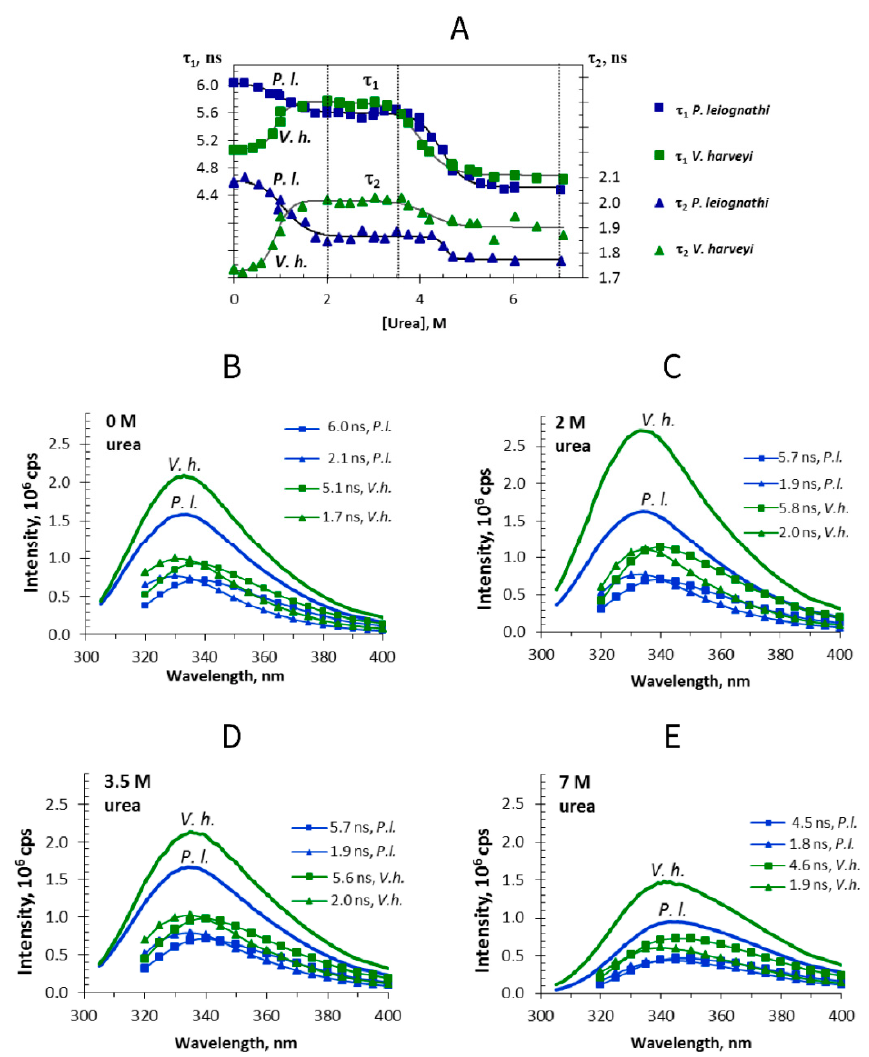
Figure 1. Dependence of the fluorescence lifetime components τ 1 (squares) and τ 2 (triangles) on urea concentration for P. leiognathi (blue) and V. harveyi (green) luciferases ( A ), and the steady-state fluorescence spectra of native ( B ), intermediate ( C , D ) and unfolded ( E ) states of luciferases (excitation at 296 nm, protein concentration is 1.7 µ M). In panel ( A ), vertical dotted lines refer to the urea concentrations at which the fluorescence spectra are shown in panels ( C – E ); solid lines represent fitting to a double Boltzmann function. By marked lines in panels ( B – E ) the decay-associated spectra based on Equation (2) are shown for the lifetime components.